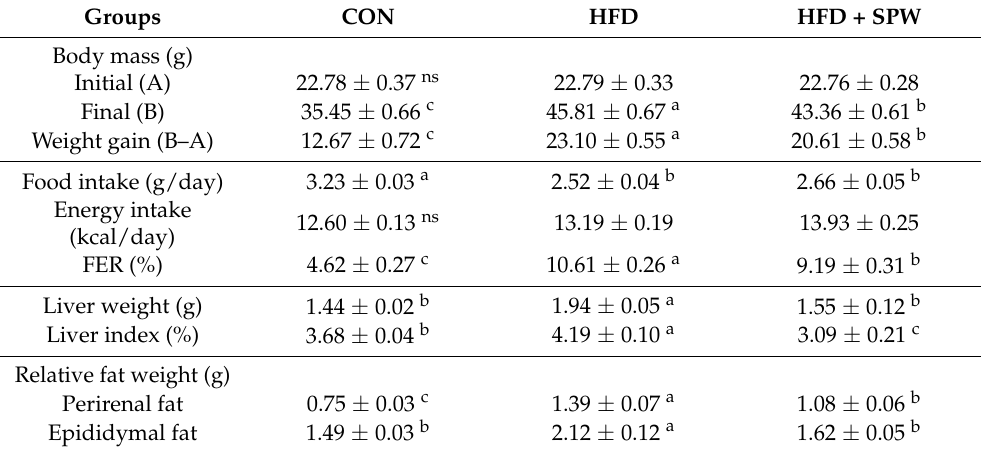
Figure 1. Salvia plebeia R. Br. water extract (SPW) treatment decreased lipid accumulation in free fatty acid-induced HepG2 cells. ( A ) Cytotoxicity was determined using the XTT assay. ( B ) Intracellular triglyceride was measured using the AdipoRed TM assay, and ( C ) lipid accumulation was measured using Oil Red O staining. Quantitative lipid accumulation of Oil Red O contents at 500 nm. ( D ) Oil Red O staining image of HepG2 cells. Data are expressed as mean ± SD ( n = 4 for each group). CON, control; FFA, free fatty acid; TG, triglyceride; XTT, 2,3-bis [2-methoxy-4-nitro-5-sulfophen-yl]-2H-tetrazolium-5-carboxyanilide; SD, standard deviation; ns., not significant; SPW 50, FFA + SPW 50 µ g/mL; SPW 100, FFA + SPW 100 µ g/mL. Different letters above the bar indicate statistical difference based on the Duncan’s multiple range test ( p < 0.05, a > b > c). Table 3. Regulatory effect of SPW on simple steatosis in high-fat diet-induced NAFLD mice.